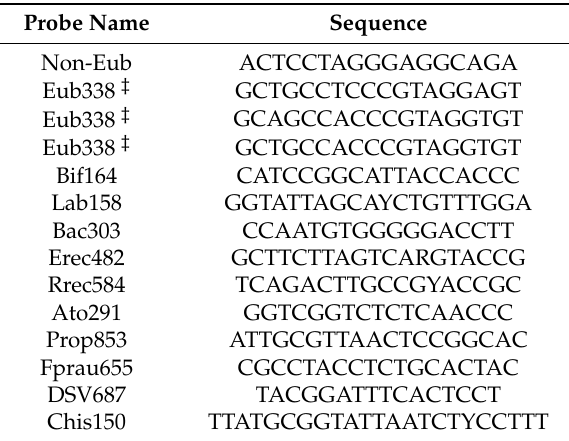
Table 1. Oligonucleotide probe